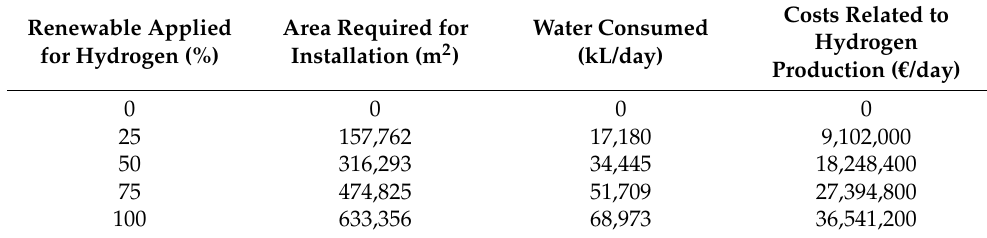
Table 9. Area, water, and costs associated with hydrogen production.